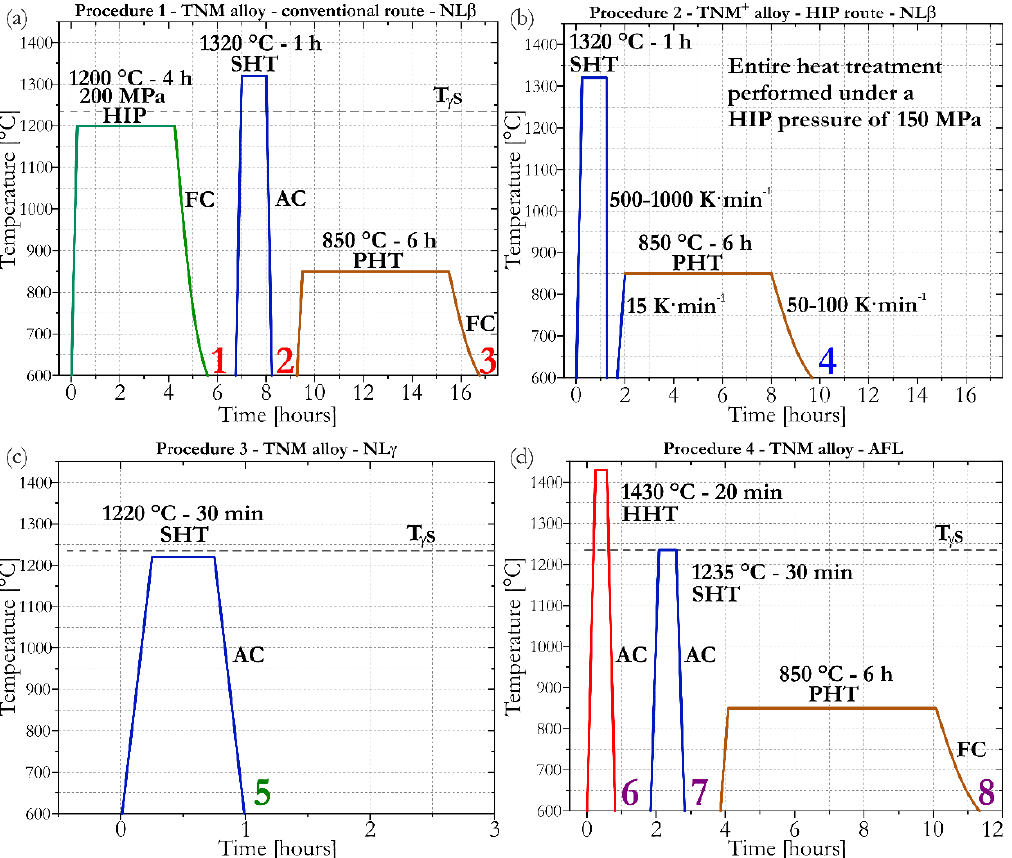
Figure 2. Schematic overview of the heat treatment studies conducted in this work, heat treatment procedures 1 – 4 ( a – d ). The heading of each diagram also indicates the microstructures aimed for. Hot isostatic pressing (HIP) treatments are drawn in green color, solution heat treatments (SHT) are drawn in blue color, homogenization heat treatments (HHT) are drawn in red color and precipitation heat treatments (PHT) are shown in brown. In addition, the respective T γ S is drawn as a horizontal line and several investigated microstructural states are marked with colored numbers.